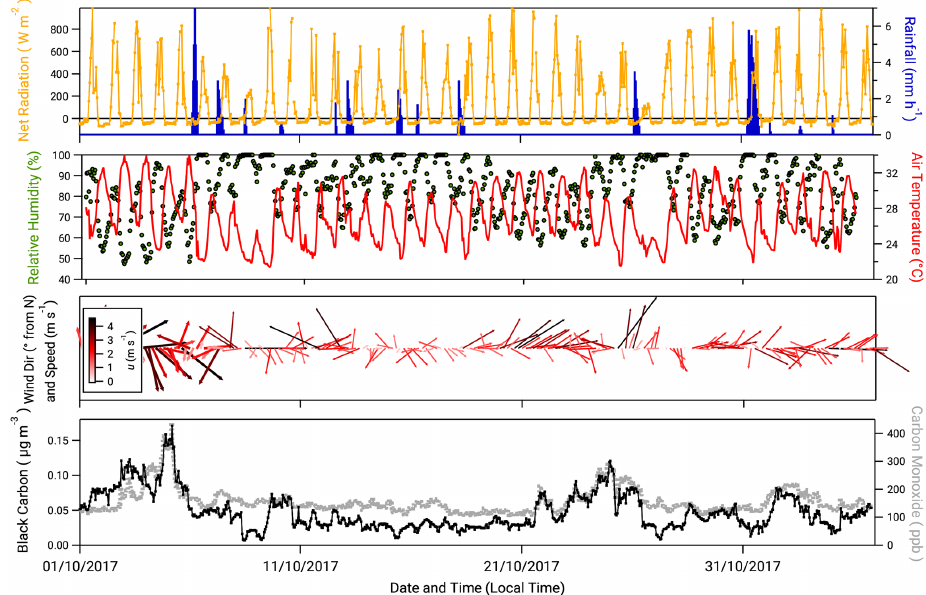
Figure 1. Meteorological and supplementary measurements taken during the campaign. From top, net radiation, hourly rainfall, relative humidity, air temperature, wind speed and wind direction (arrows scaled to wind speed and orientated from 0 ◦ N) and concentrations of black carbon and carbon